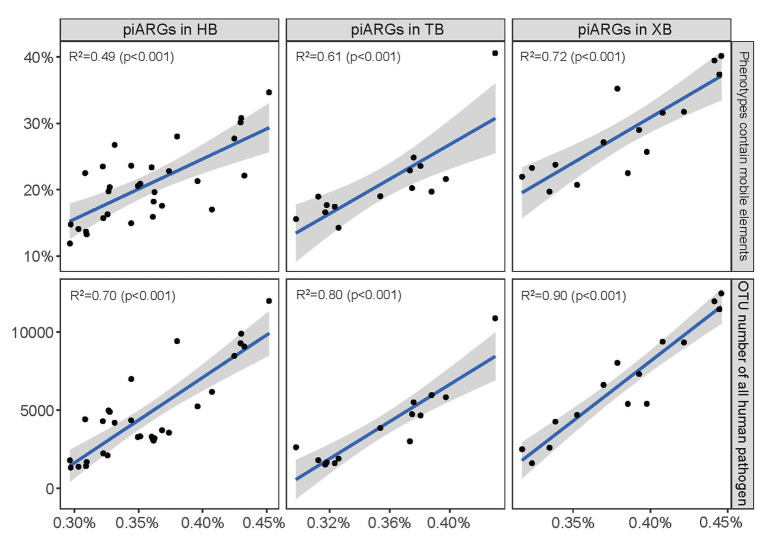
Linear regression model showed the relationships between piARG abundance and proportion of phenotypes containing mobile elements, OTU number of all human pathogen in the three bays. The solid lines indicate significant relationships. The shaded areas show the 95% confidence interval of the fit.